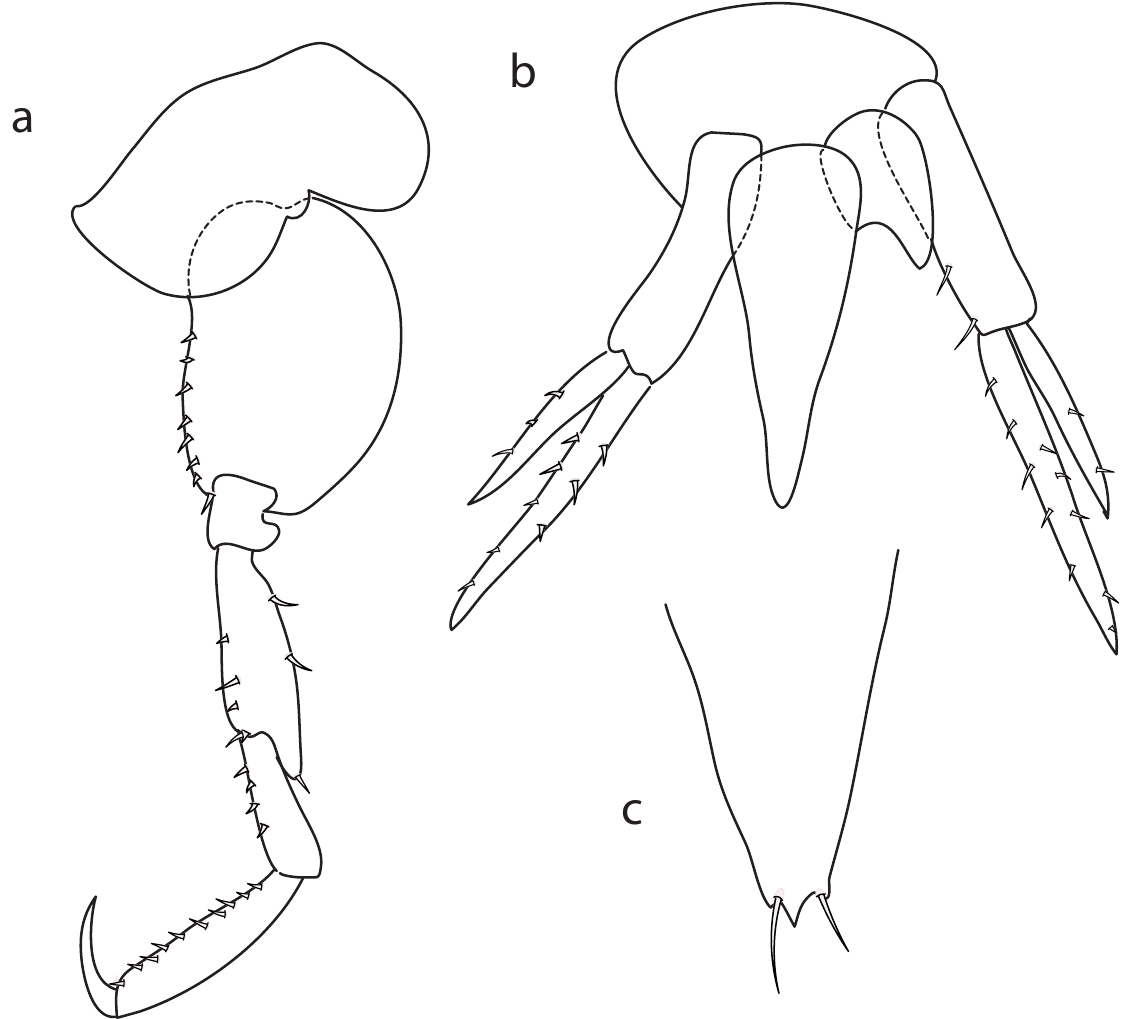
Fig. 23. Leucothoe kawesqari Esquete & Aldea, 2015 . a . Pereopod 5. b . Urosome with uropod 2 and telson. c . Telson tip. Figure not